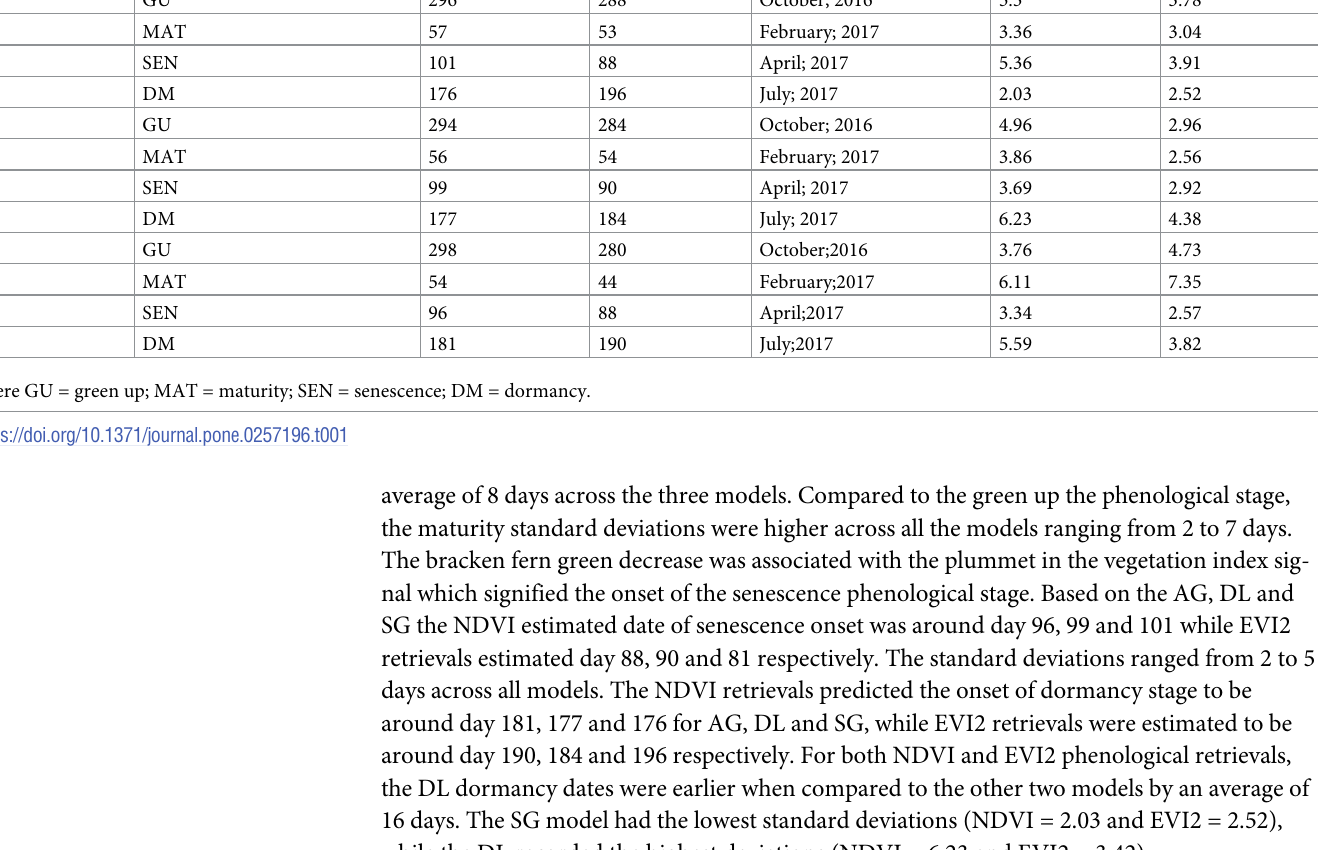
Table 1. Mean phenological dates and standard deviations for the three models embedded in TIMESAT. Model Phenological metric